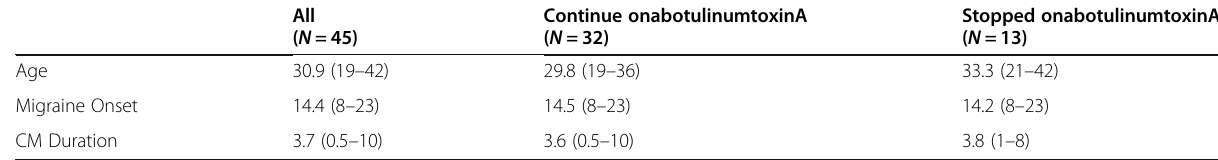
Table 1 Patient Demographics: Characteristics of pregnant patients exposed to OnabotulinumtoxinA All ( N =